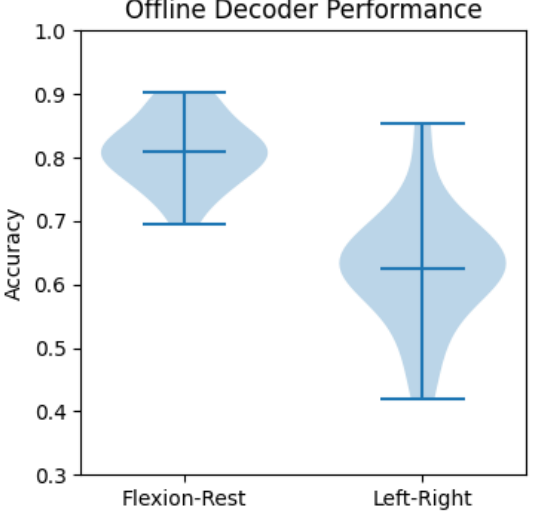
Figure 10. Offline decoder’s performance.